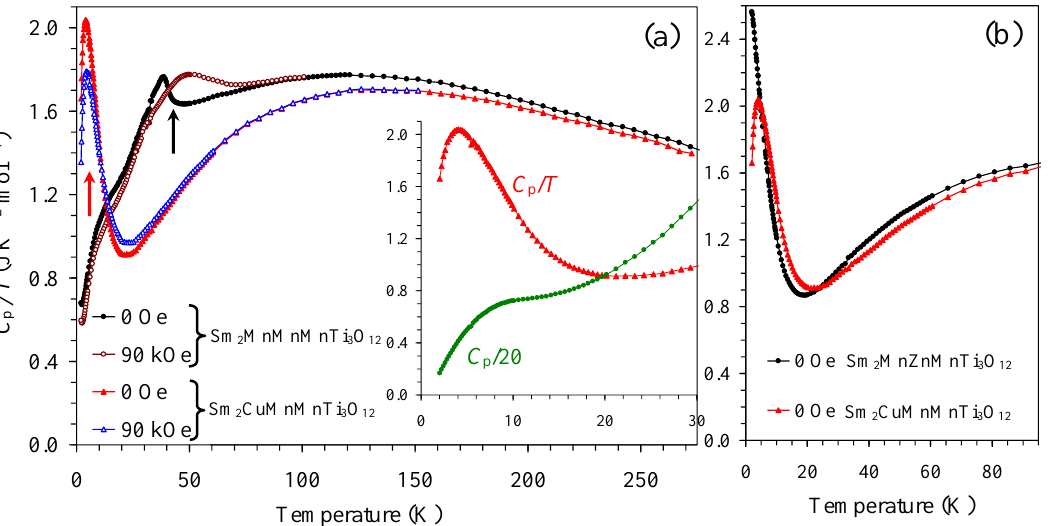
Figure 9. ( a ) C p / T versus T curves of Sm 2 CuMn(MnTi 3 )O 12 at H = 0 Oe (red triangles) and 90 kOe (blue triangles) in comparison with the parent compound Sm 2 MnMn(MnTi 3 )O 12 at H = 0 Oe (black circles) and 90 kOe (brown circles). C p is the total specific heat. The arrows show the positions of the magnetic anomalies. The inset shows the C p / T versus T curve at H = 0 Oe below 30 K, and the C p versus T curve at H = 0 Oe (green circles). For the C p versus T curve, the C p values were divided by 20, and the C p unit is J K − 1 mol − 1 . ( b ) Comparison of C p / T versus T data for Sm 2 CuMn(MnTi 3 )O 12 (red triangles) and Sm 2 MnZn(MnTi 3 )O 12 (black circles) [34] at H = 0 Oe.